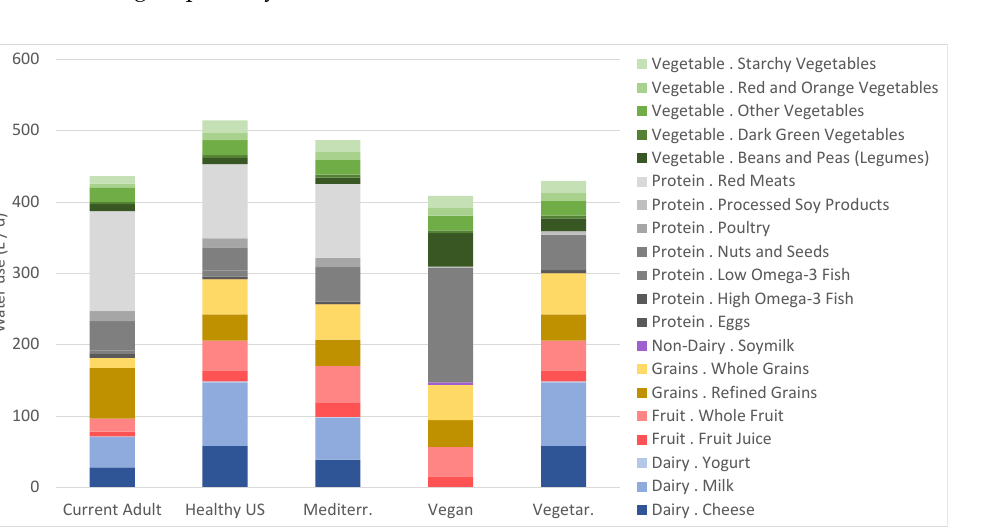
Figure 2. On-farm water use requirements for five diets reflecting an average of 2000 kcalories (recommended diets) or 2155 calories (Current diet), with major food group (dairy, fruit, grains, non-dairy, protein, and vegetable) and subgroups indicated by column colors.